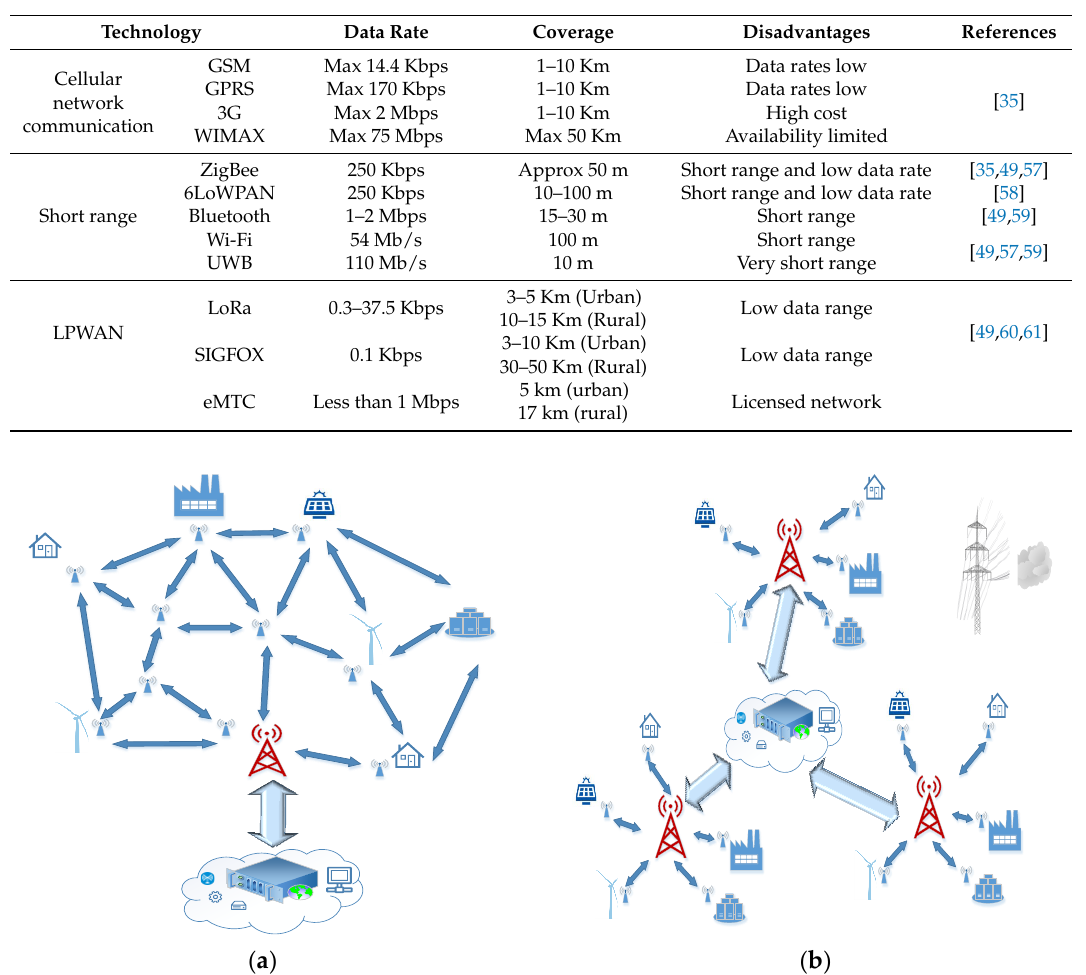
Table 2. Comparison of different wireless technologies for M2M communication.